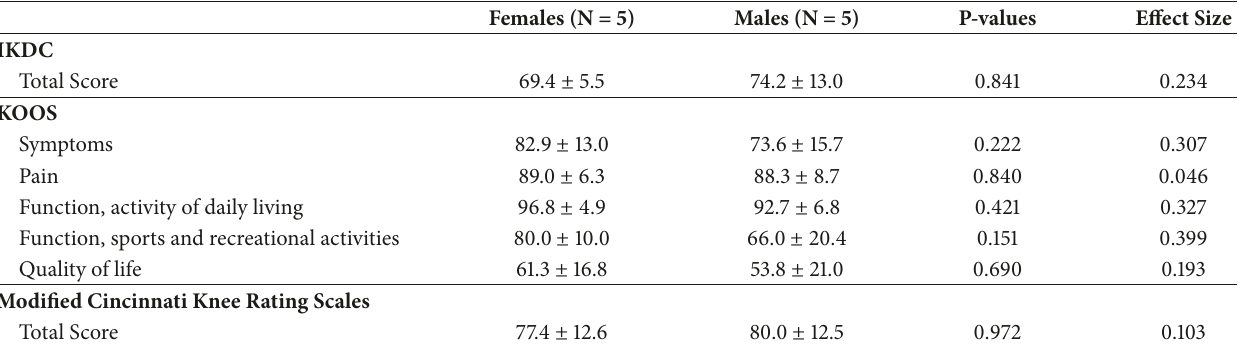
Table 5: Comparison of the patients’ reported outcome scores by